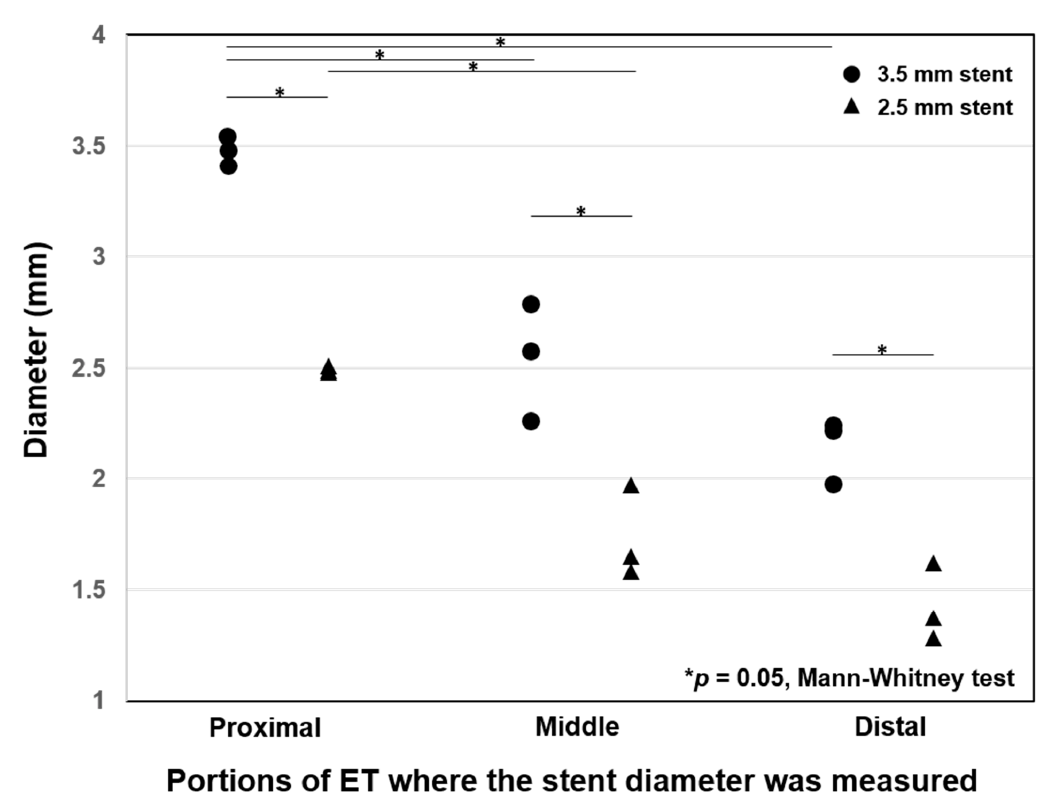
Figure 2. Longest luminal diameter of the stent measured at the proximal, middle, and distal portions of the porcine Eustachian tube (ET) model.